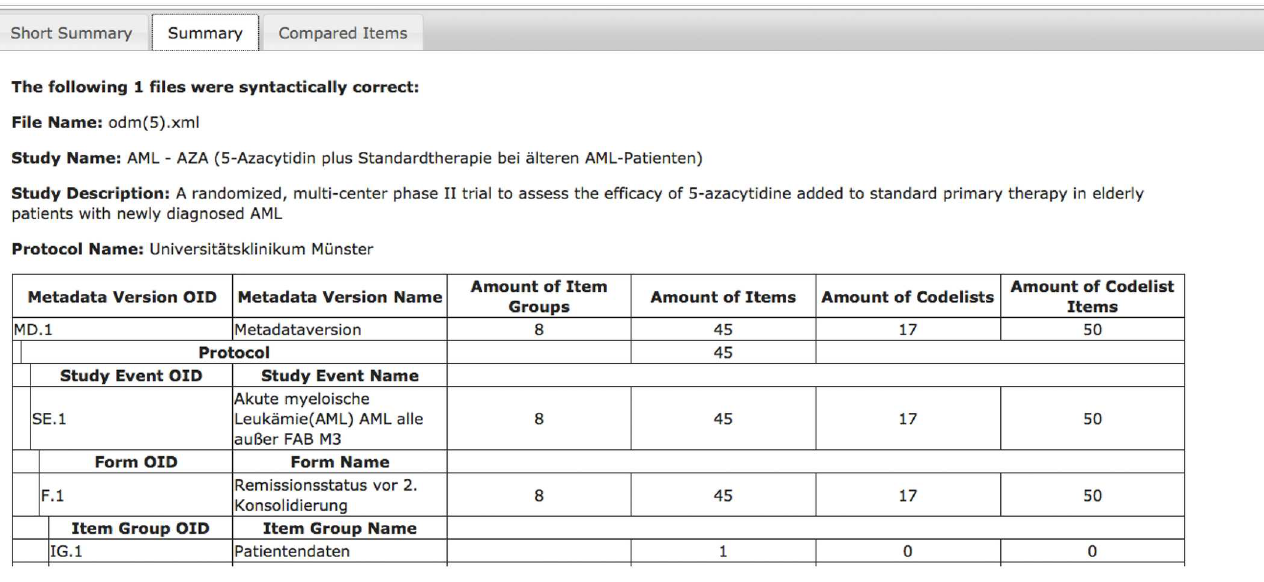
Fig 6. Summary of ODM-files’